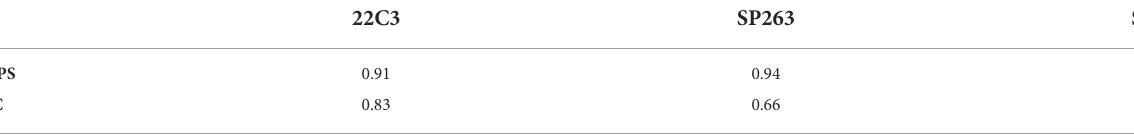
TABLE 6 Inter-observer agreement according to assay and scoring algorithm (Cohen's